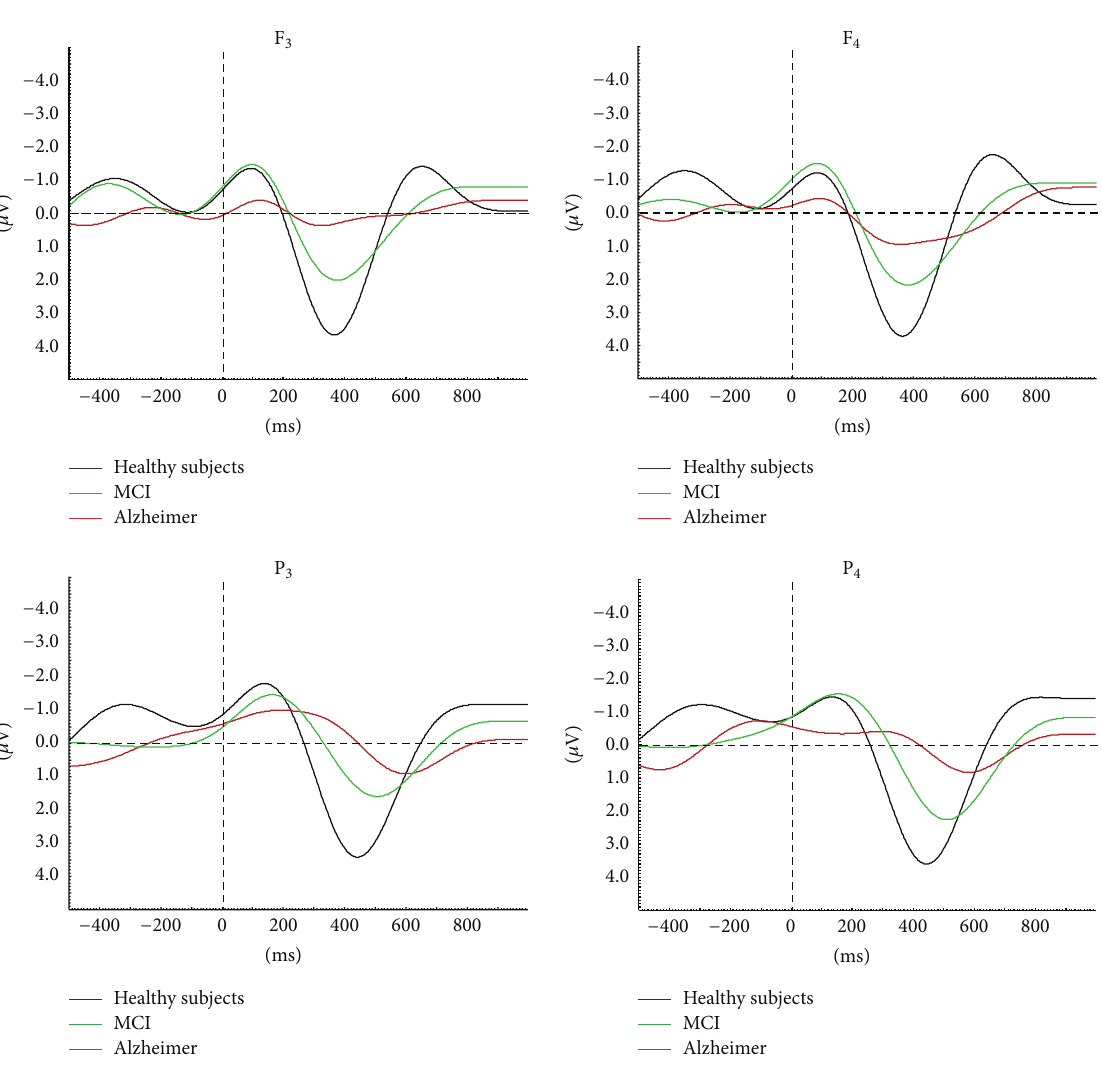
Figure 6: MCI and AD continuity is prominent in auditory event-related delta oscillatory activity. Results show gradually decreasing delta amplitude and increasing delta peak latency among healthy elderly subjects, MCI, and mild-stage Alzheimer subjects. MCI: mild cognitive impairment; AD: Alzheimer’s disease